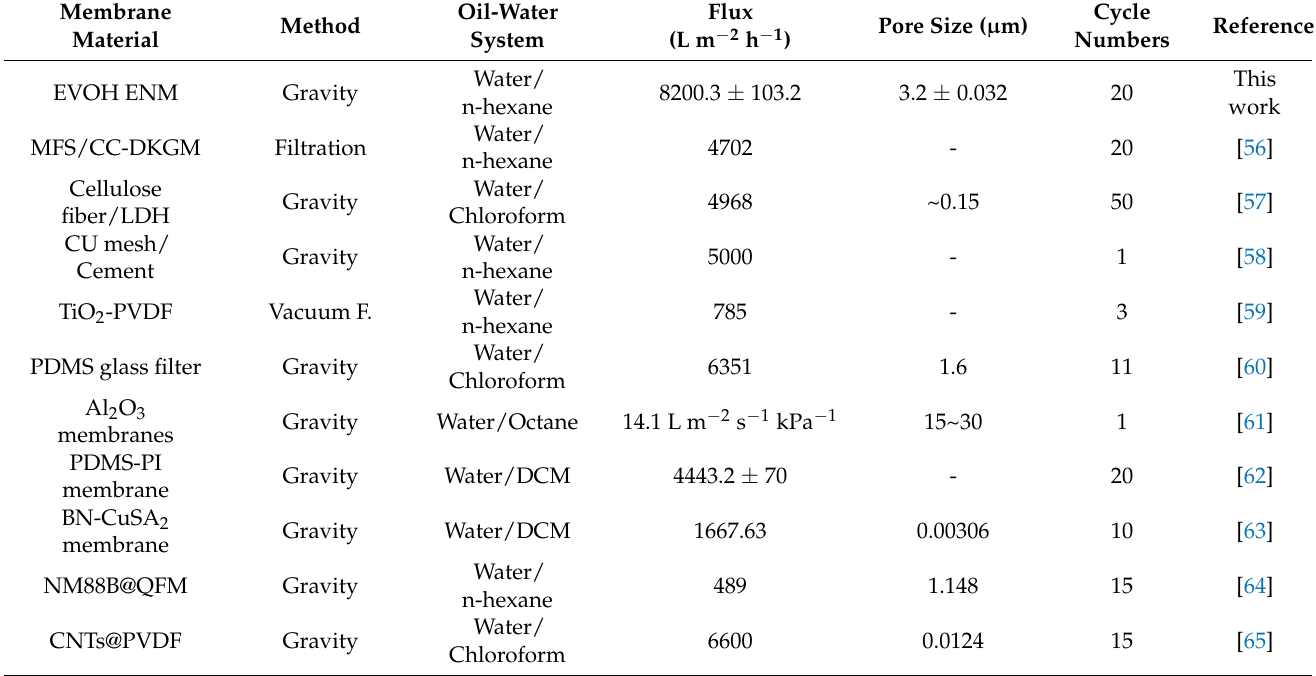
Table 2. Oil–water separation performance comparison between EVOH ENM and literature